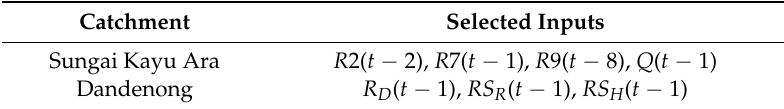
Table 3. Selected inputs for Sungai Kayu Ara and Dandenong